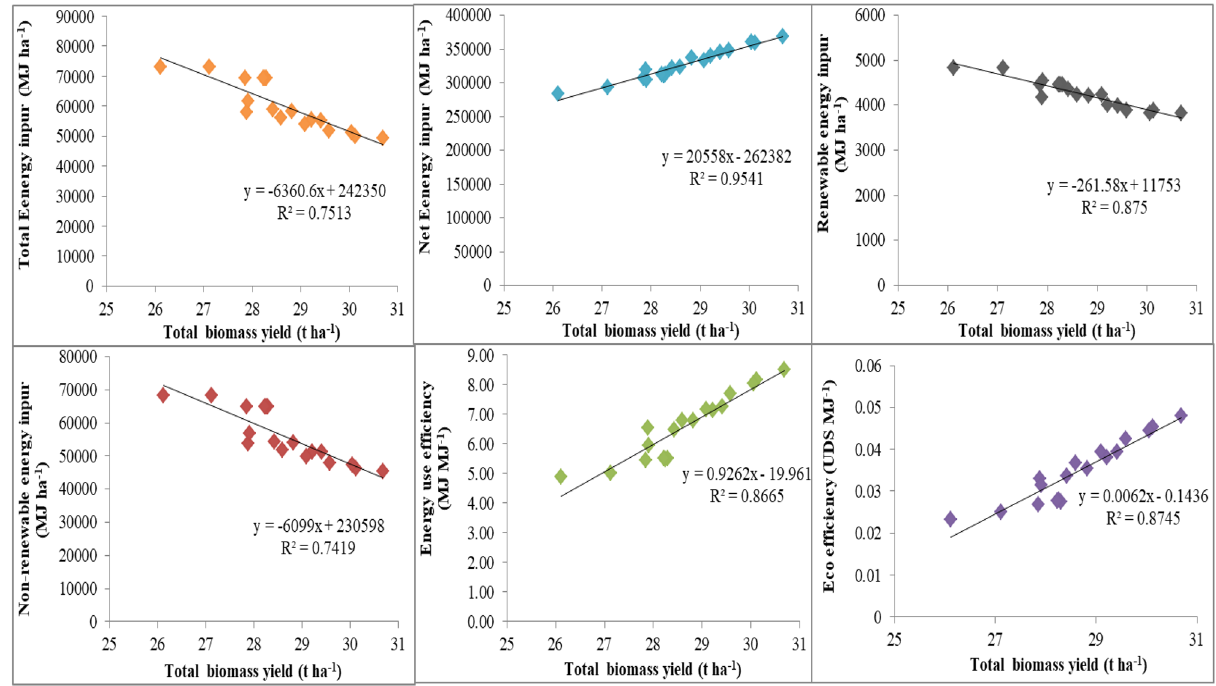
Figure 6. The relationship between the biomass yield and energy parameters (total energy inputs, net energy input, renewable and non-renewable energy inputs, energy and eco-